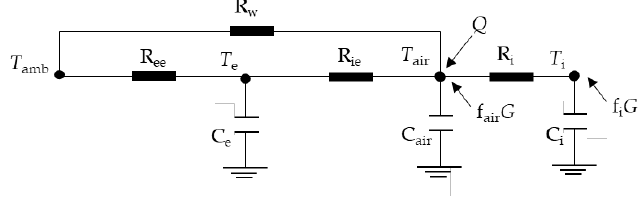
Figure 2. Thermal network for building model.